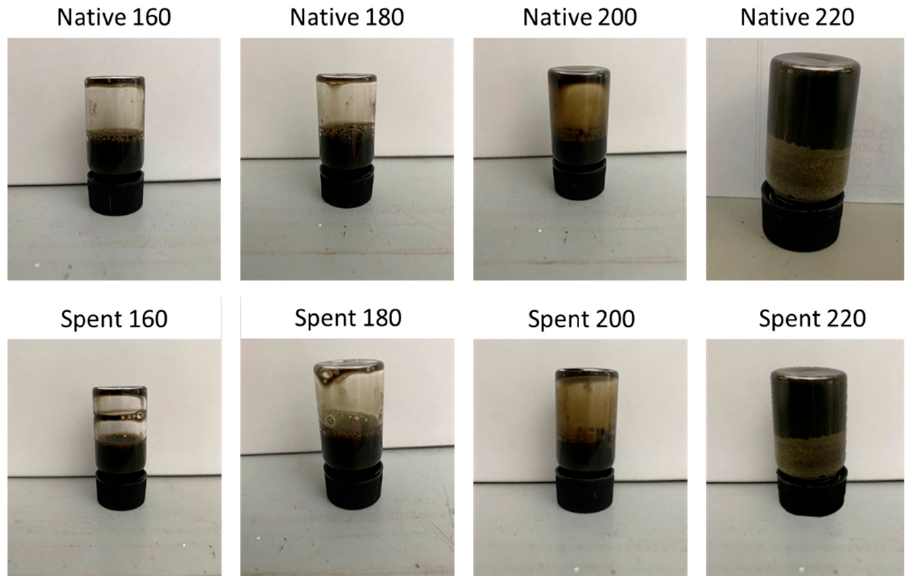
Figure 1. Hydrogels formed from defibrillated cellulose samples obtained from native algal biomass and spent algal biomass. Numbers refer to the temperature in ° C of the microwave process used for production of the D.C.